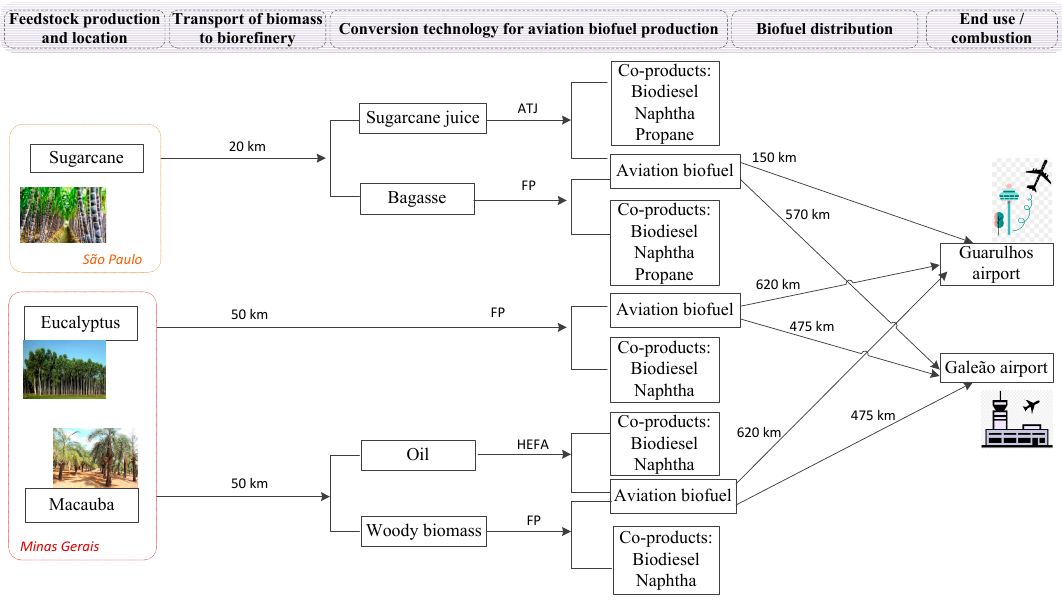
Figure 1. Scope of aviation biofuel supply chains for the comparative analysis of LCIA methods on human health-related impacts.